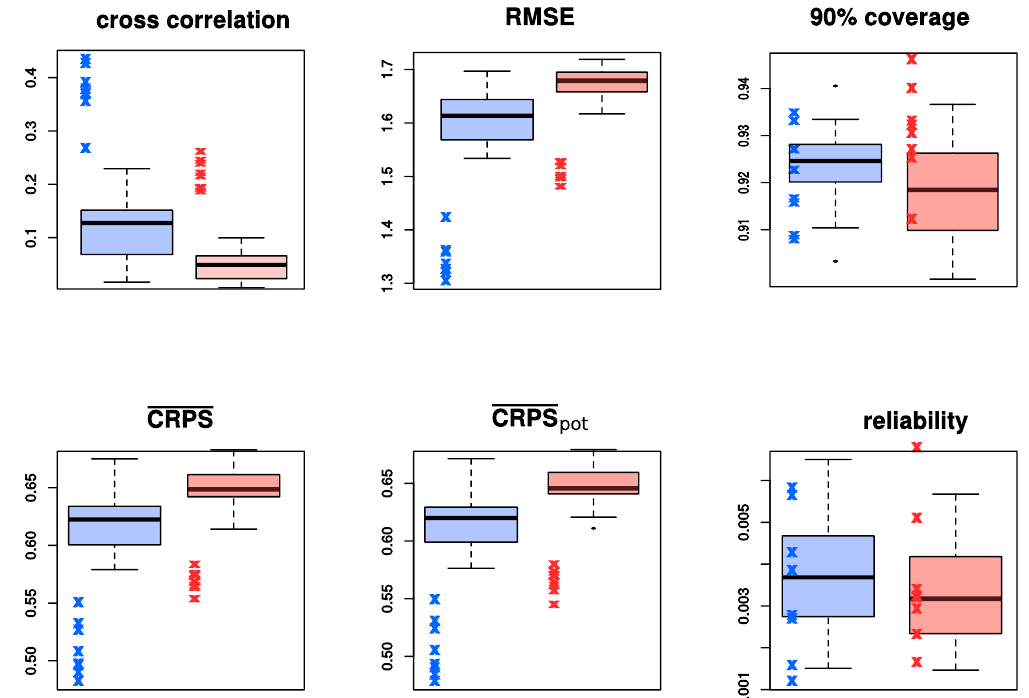
Figure 7. Experimental results with eight time-uncertain proxies and no instrumental data. Blue: results using BARCAST+AMS. Red: results using random age model selection. Results for the proxy locations are shown as crosses, while results at other locations, where there are no observations, are displayed with box